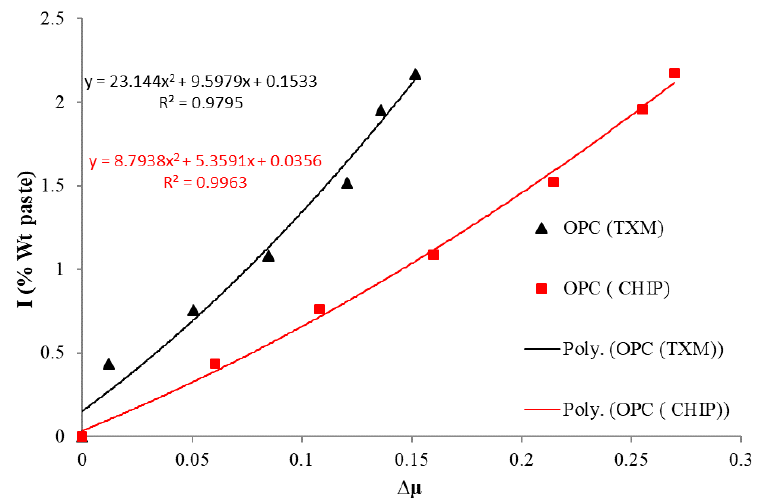
Figure A5. Calibration curves for mortar (w/cm = 0.4) that was used to calculate concentrations in concrete samples.